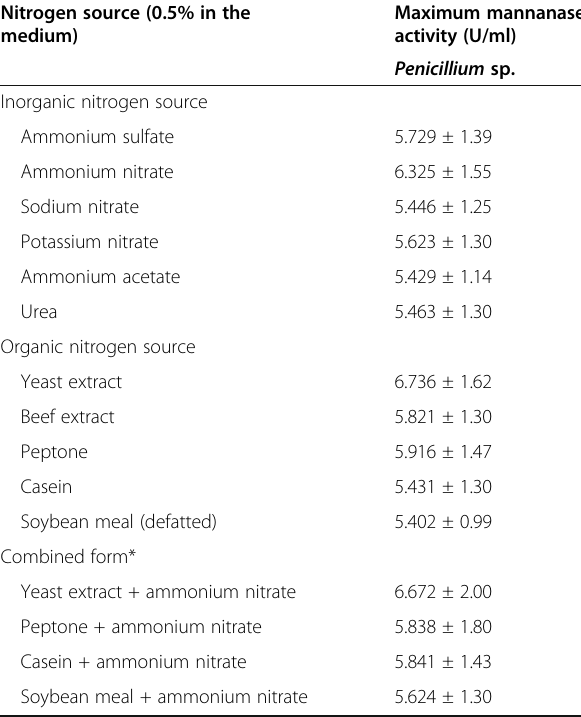
Table 2 Effect of various nitrogen sources on production of alpha-galactosidase (using 2% defatted copra meal, dFCO) Nitrogen source (0.5% in the medium)